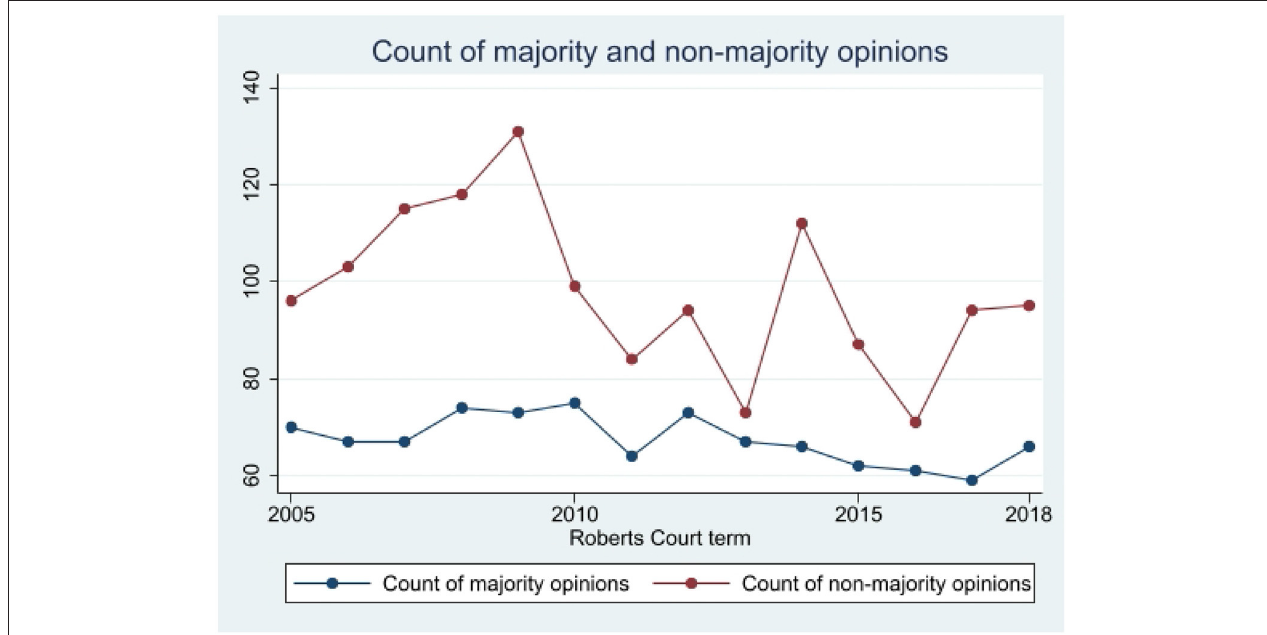
FIGURE 4 | Count of majority and non-majority